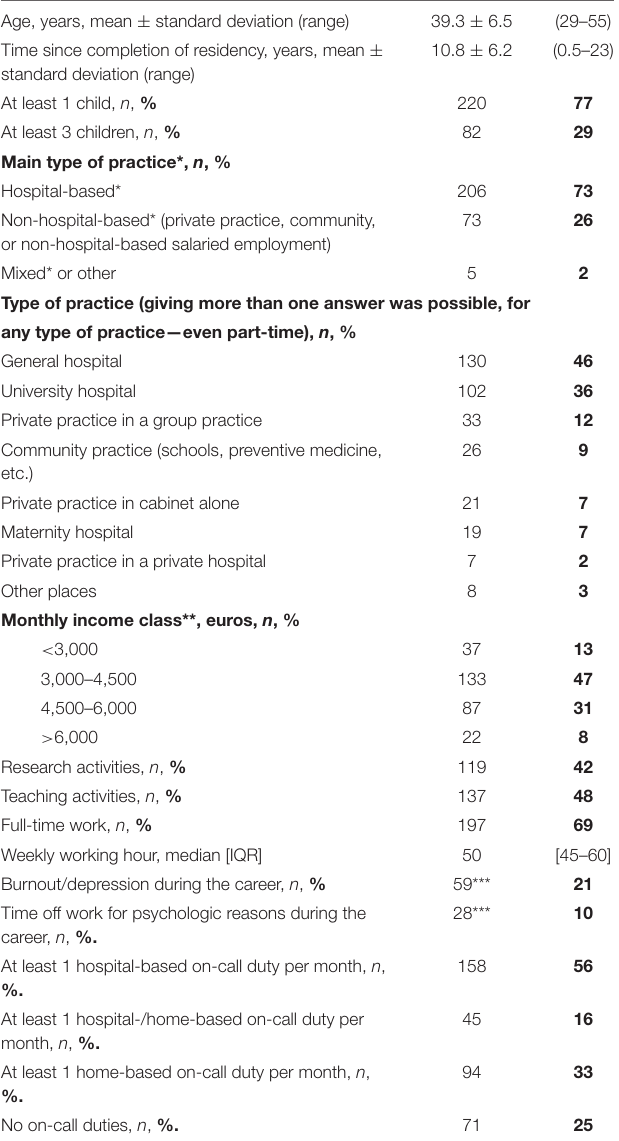
TABLE 3 | Characteristics of the current practice of former pediatric residents at LUMC ( n = 284). Age, years, mean ± standard deviation